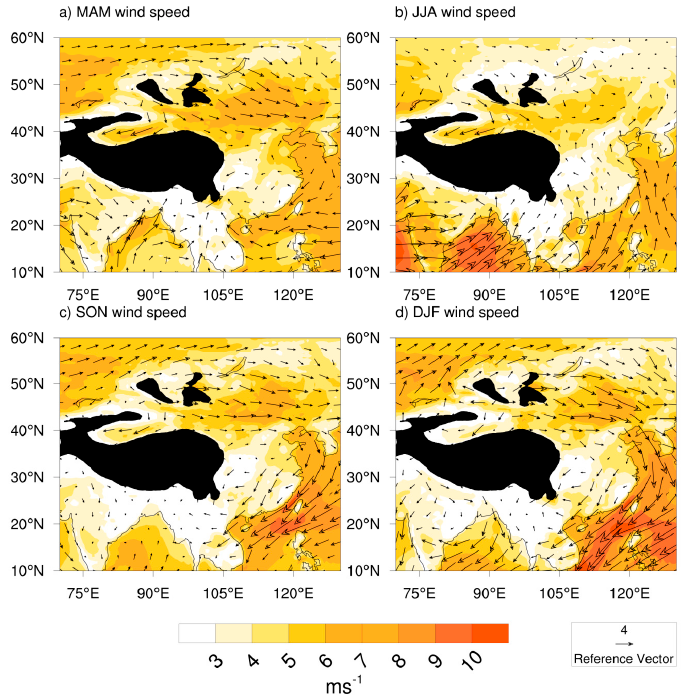
Figure 3. Wind speed climatology and wind vector characteristics between 1979 and 2014 ( a ) in spring Figure (MAM, March-April-May); ( b ) summer (JJA, June-July-August); ( c ) autumn (SON, September- October-November); and ( d ) winter (DJF, December-January-February).